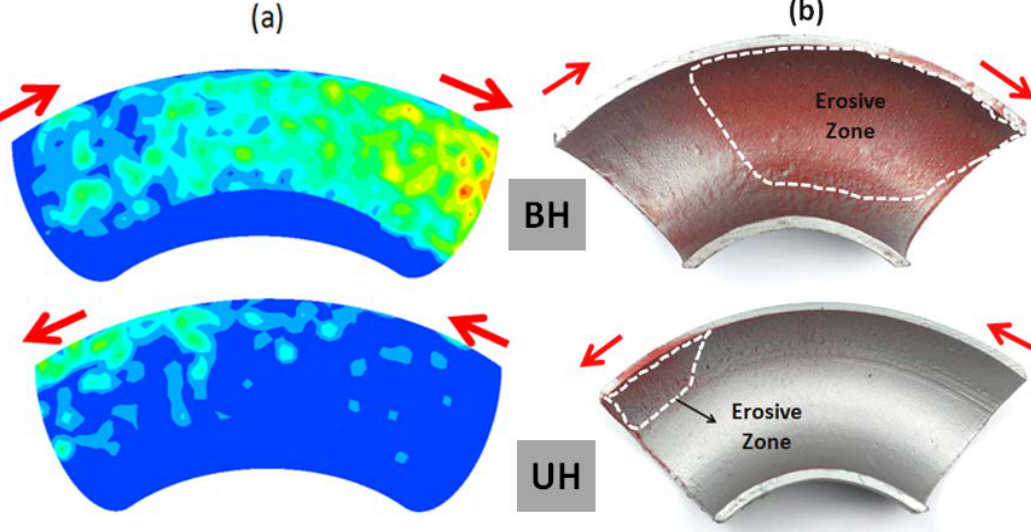
Figure 10. Erosion zone at the elbow internal wall for a slurry velocity of 4 m/s: ( a ) discrete phase